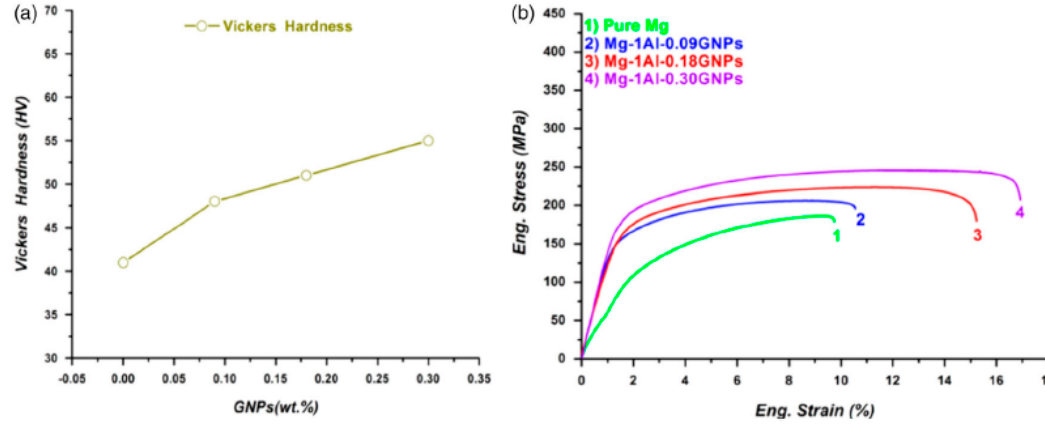
Figure 14. Mechanical properties of pure Mg and its nanocomposites at room temperature: ( a ) Vickers hardness, and ( b ) tensile stress–strain curve [59] (Copyright Elsevier, 2015, Materials Science and Engineering: A).